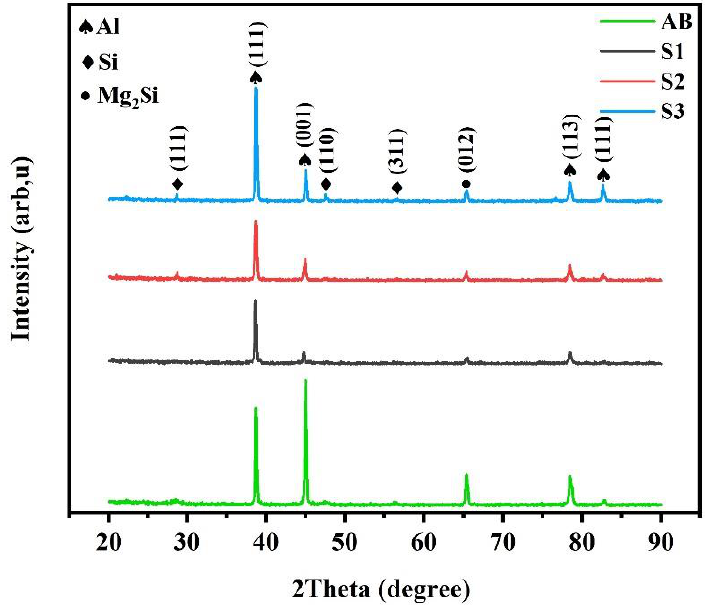
Figure 5. XRD patterns for BM (as-built material: AB) and SZ of different FSPed samples.